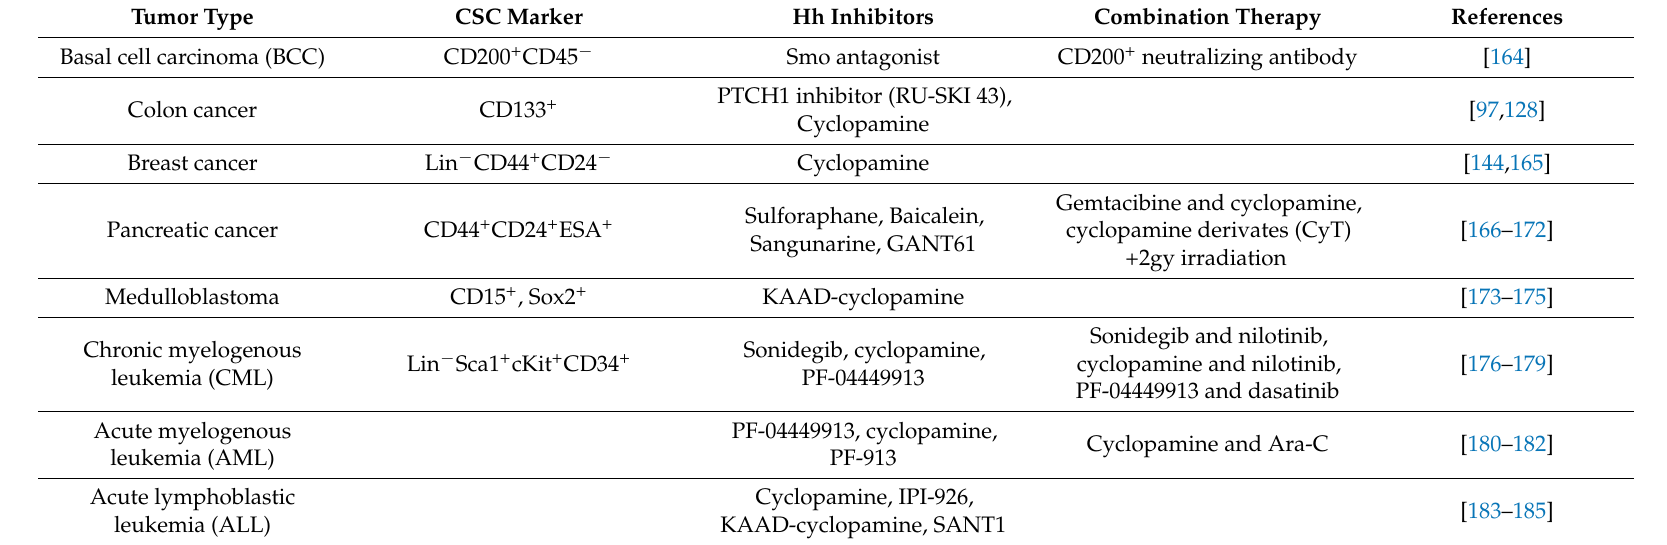
Table 2. Hedgehog signaling inhibition in cancer stem cells